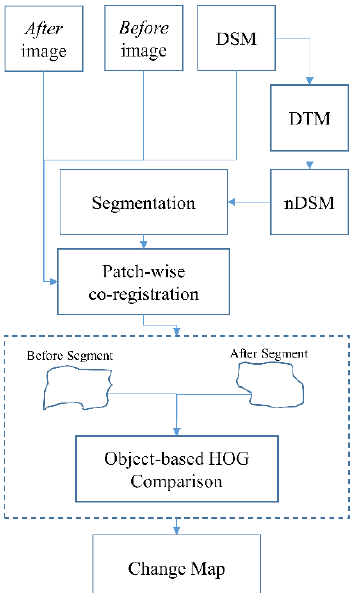
Figure 1: Proposed method of damage detection